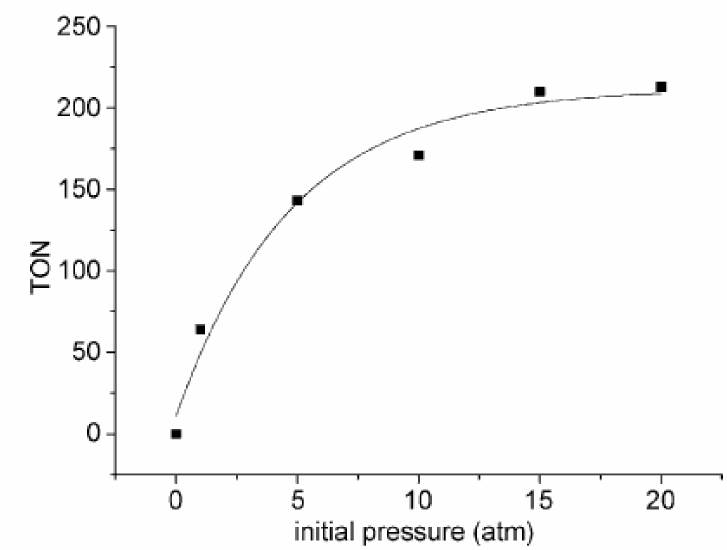
Figure 2. Effect of initial pressure on acetylene hydrocarboxylation. Reaction conditions: [Pd 2 (dba) 3 ] · CHCl 3 (2.5 mmol), Xantphos (50 mmol), benzoic anhydride (0.1 mmol), HCO 2 H (1.5 mmol),